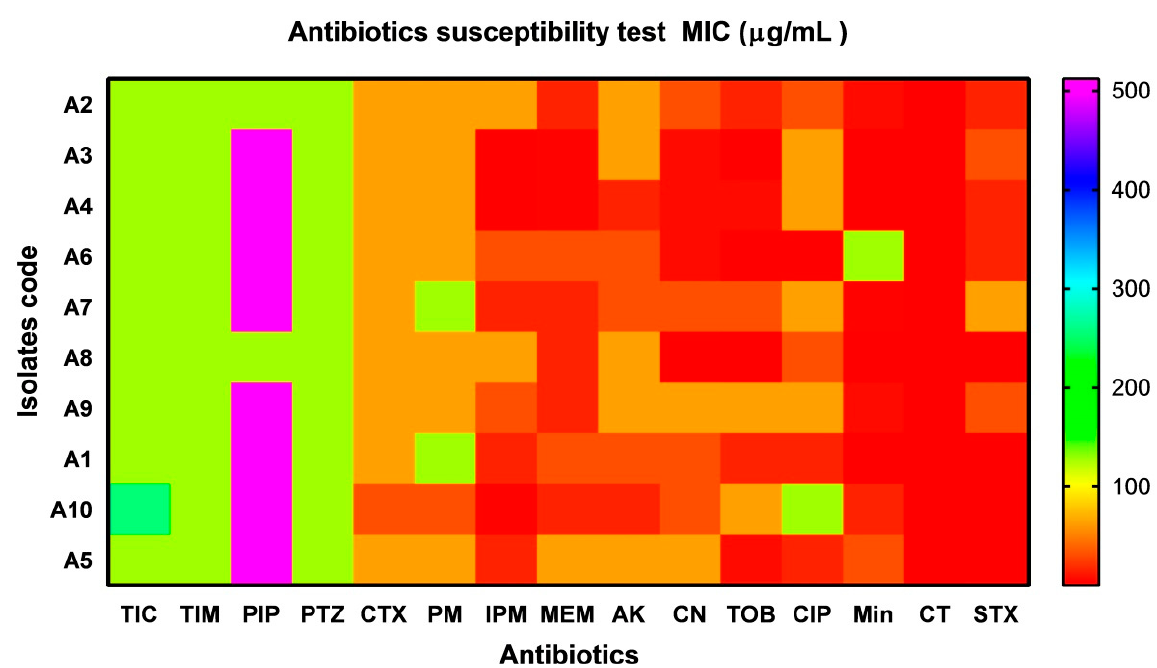
Figure 2. The heat-map illustrates the antibiograms for all the recovered A. baumannii isolates (A1: A10) by ViteK-2 systems. The intensity of colors indicates the numerical value of the MIC (µg/mL). TIC; Ticarcillin: TIM; Ticarcillin/Clavulanic Acid: PIP; Piperacillin; PTZ; Piperacillin/Tazobactam: CTX; Cefotaxime: PM; Cefepime; IPM; Imipenem: MEM; Meropenam: AK; Amikacin: CN; Gentamicin; TOB; Tobramycin: CIP; Ciprofloxacin: Min; Minocycline: CT; Colistin: SXT; Trimethoprim/Sulfamethxazole. Interpretations breakpoint of antibiotic susceptibility is based on CLSI criteria. Table 2. Virulence and antibiotic resistant genes for the Acinetobacter baumannii isolates. Virulence Genes Antibiotic Resistance Genes Types of Samples (Isolate No.) rec